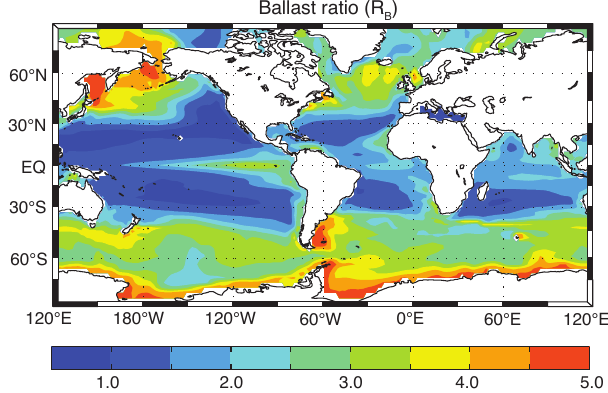
Figure A1. Ballast ratio (ratio of the mass flux of ballast minerals to the mass flux of organic carbon at the base of the euphotic zone) calculated from the